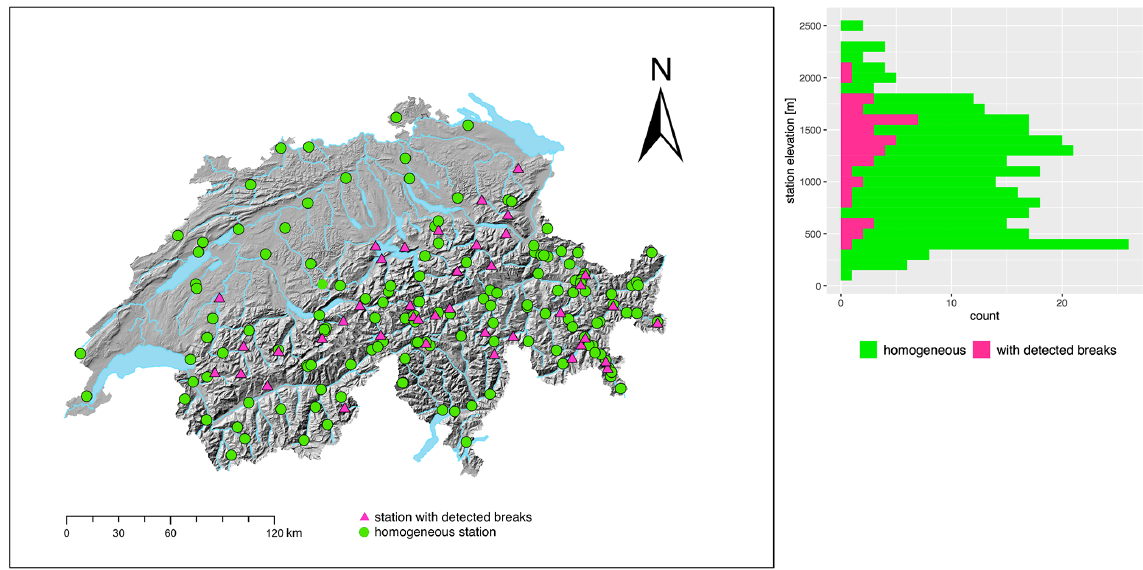
Figure 1. Left panel: map of Switzerland with all 184 Swiss stations used in this study. The 40 identified inhomogeneous stations with valid break points are highlighted in pink triangles. The green circles are series that are considered homogeneous. Right panel: elevation distribution of the homogeneous stations and those with detected